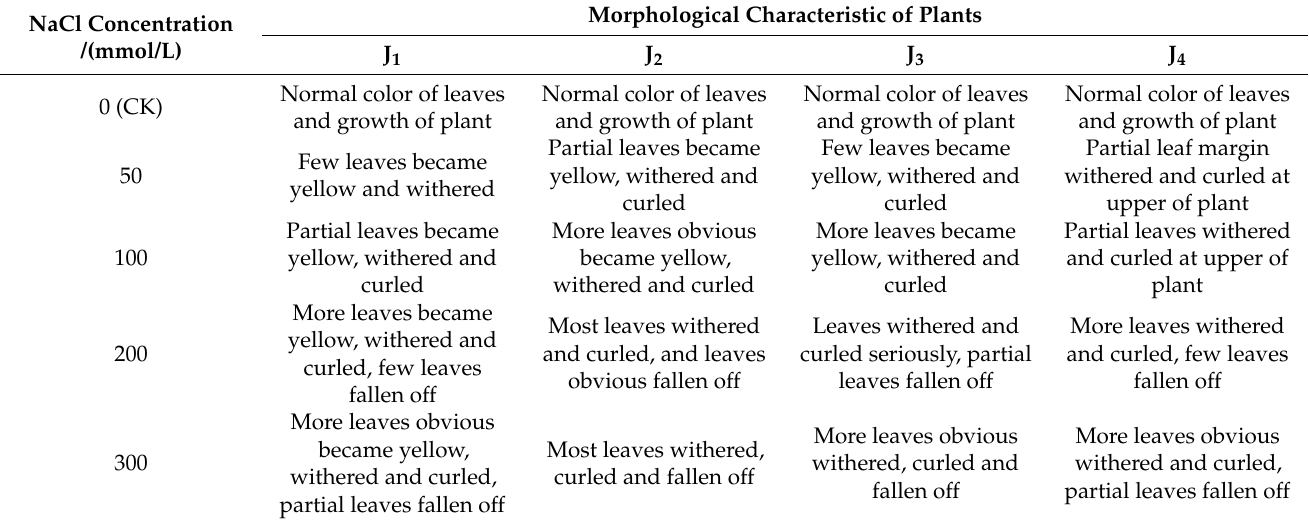
Table 1. Morphological characteristics of 4 different walnut genotypes under NaCl stress.